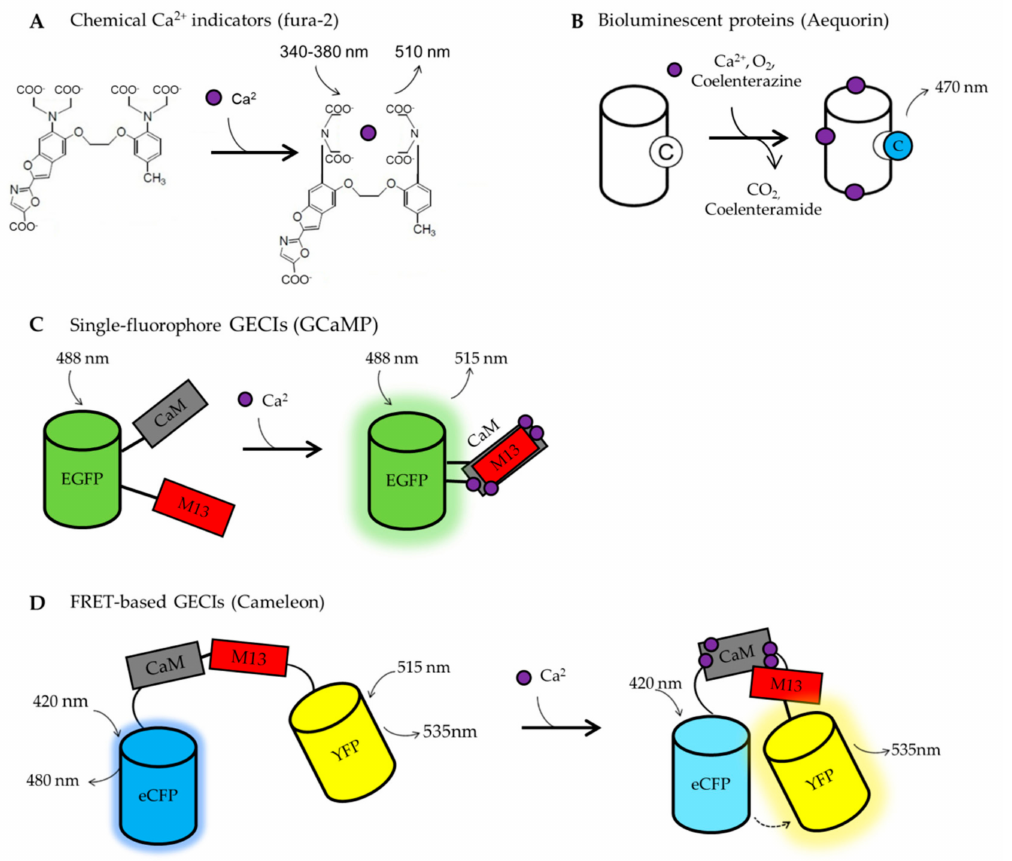
Figure 2. Indicators. ( A ) Chemical calcium indicators: fura-2. Following the binding of Ca 2 + to fura-2, the probe emission, at 340 nm of excitation, increases, whereas that at 380 nm decreases. The 340 / 380 ratio is dependent on Ca 2 + concentration. ( B ) Bioluminescent proteins: Aequorin. When Ca 2 + binds aequorin, the prosthetic group of coelenterazine ( C , left side) oxidates to coelenteramide ( C , right side), emitting a photon at 470 nm. ( C ) Single-fluorophore-based GECIs: GCaMP. Binding of Ca 2 + to GCaMP leads to conformational changes between the two Ca 2 + responsive elements that increase the emitted fluorescence. ( D ) FRET-based GECIs: Cameleon. Binding of Ca 2 + to CaM, induces a conformational change between CaM and M13 that enables FRET between donor and acceptor